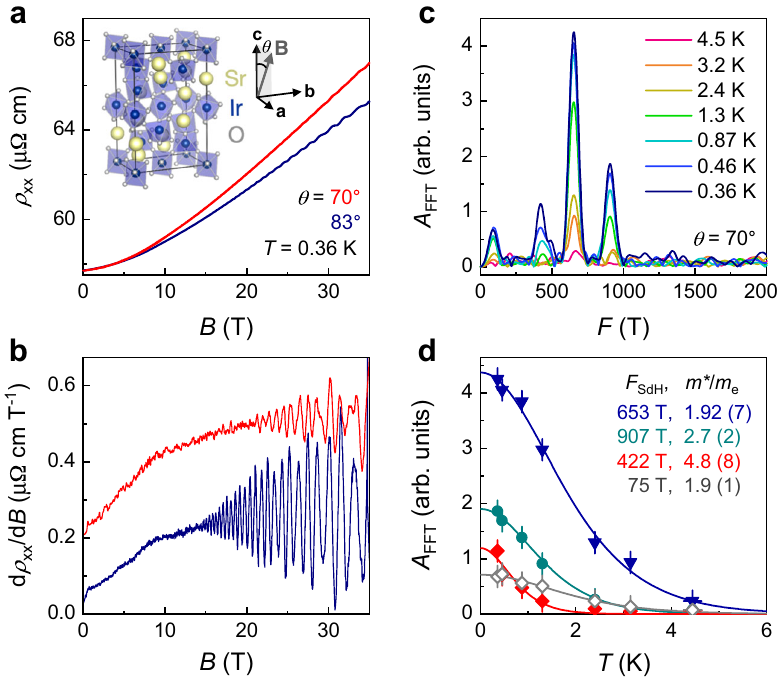
Fig. 1 Shubnikov-de Haas oscillations in monoclinic SrIrO 3 . a Electrical resistivity ρ xx measured in a magnetic fi eld B up to 35 T at speci fi ed angles. Inset: crystal structure (in conventional unit cell) and experimental alignment. B is rotated within the a - c plane, with θ denoting the angle between B and the c -axis [001]. b Field-derivative of the data shown in a using the same colour coding. θ = 70 ∘ data are shifted vertically for clarity. c Fourier spectrum of the SdH oscillations measured at θ = 70 ∘ and indicated temperatures, after a polynomial background is subtracted. Four distinct peaks at F SdH = 75, 422, 653, and 907 T are resolved using a fi eld window of 18 T < B < 35 T. d Extraction of the effective masses m * through fi tting the oscillation amplitude A FFT ( T ) using the Lifshitz-Kosevich expression (see text). Error bars in A FFT re fl ect the noise fl oor of the Fourier spectra shown in c